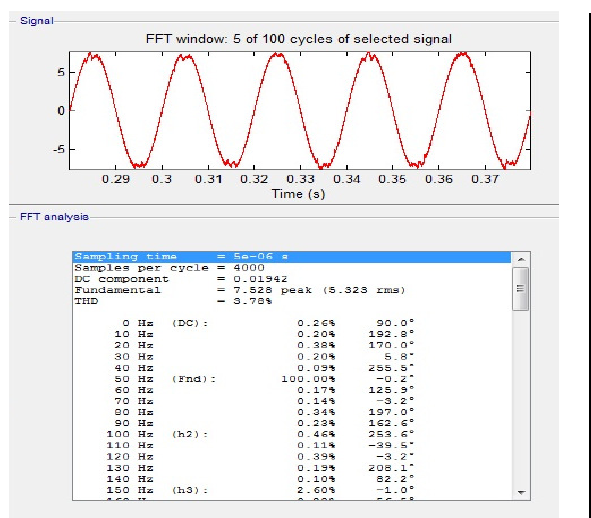
Fig 23: Current THD with FLC The comparison of controller parameters are given in Table 4. The grid current THD is obtained as 5.93% with PI controller and 3.78% with FLC. The rise time and settling time of the PI controller are 0.02s and 0.08s respectively. Using FL controller, the rise time and settling time are found to be 0.016s and 0.05s. The steady state error is found to be 0.13 for FLC and 0.2